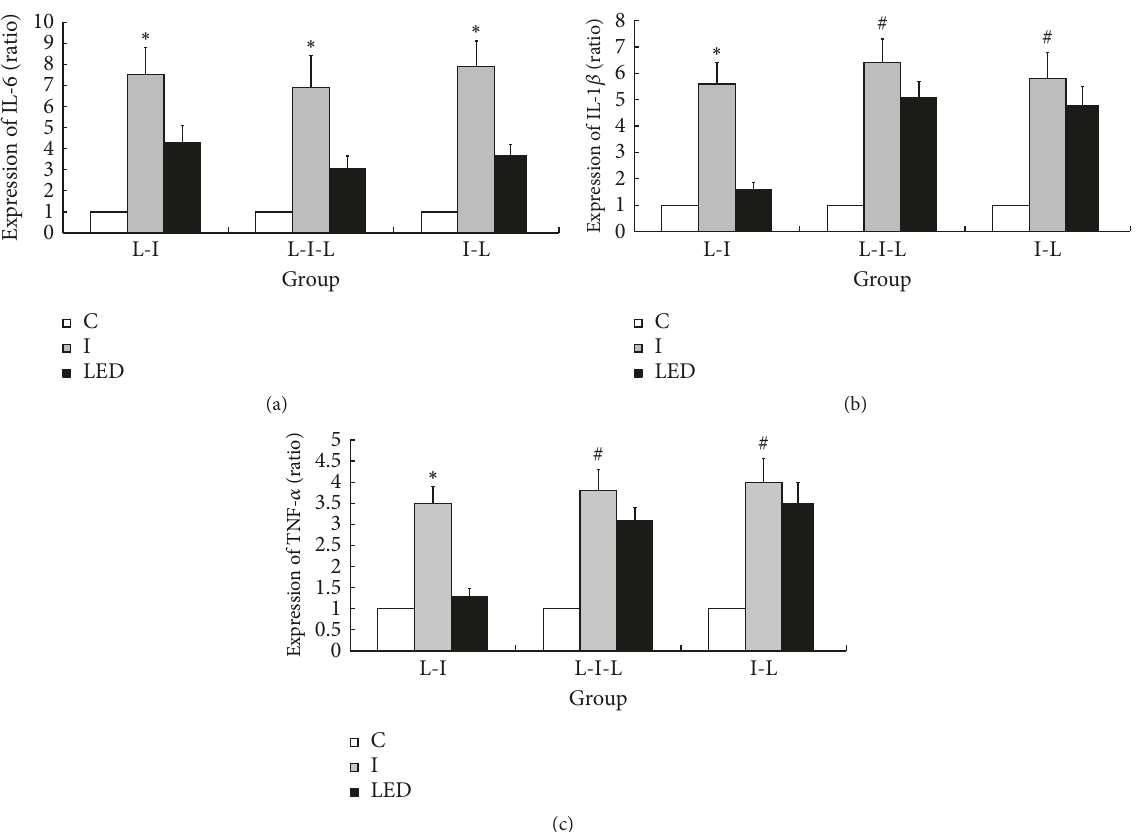
Figure 4: Changes in mRNA levels of interleukin-6 (IL-6), IL-1 𝛽 , and tumor necrosis factor 𝛼 (TNF- 𝛼 ) after LED irradiation. Compared with the C groups, significant upregulation of IL-1 𝛽 , IL-6, and TNF- 𝛼 was noted in all the I groups (a, b, and c). Significantly decreased expression of IL-6 was noted in all the LED-irradiated groups compared with the incision only group (a). After LED irradiation, significantly decreased expression of IL-1 𝛽 and TNF- 𝛼 was noted only in the L-I group (b, c). C indicates LED irradiation for 6 days on sham skin incision in the paw contralateral to the LED-irradiated paw; I indicates incision only; L-I indicates LED irradiation for 6 days before skin incision; I-L indicates LED irradiation for 6 days after skin incision; L-I-L indicates LED irradiation from 3 days before skin incision to 3 days after skin incision. ∗ 𝑝 < 0.05 compared with the C and LED-irradiated groups; # 𝑝 < 0.05 compared with the C groups. The values represent the means ±